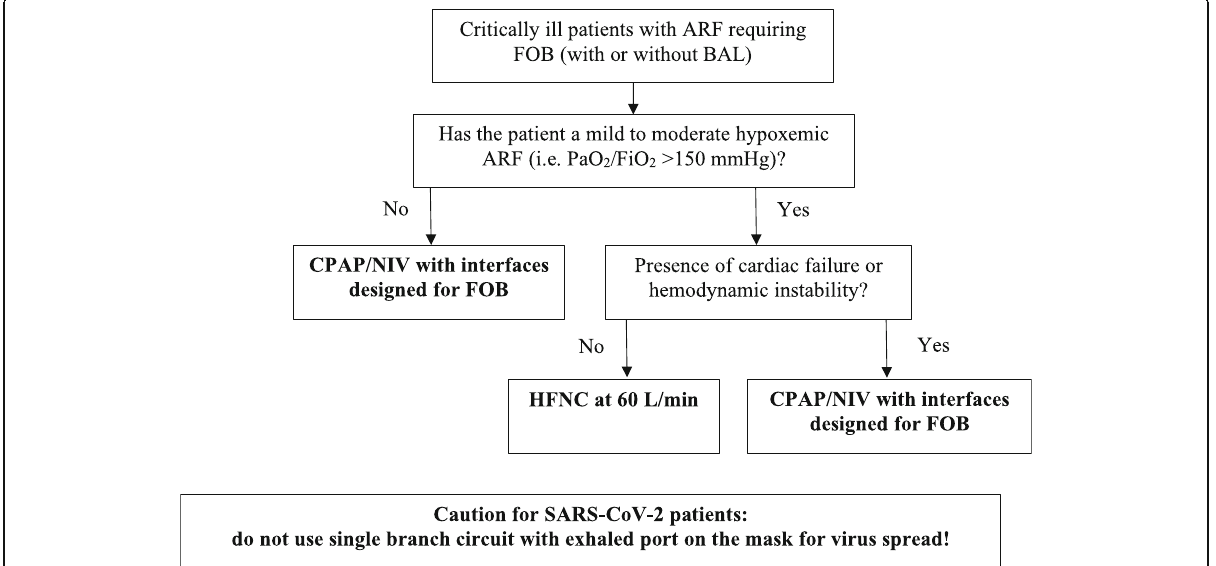
Fig. 1 Possible approach for FOB in ICU in non-intubated patients. ARF, acute respiratory failure; FOB, flexible fiberoptic bronchoscopy; BAL, bronchoalveolar lavage; PaO 2 /FiO 2 ratio between arterial partial pressure of oxygen and inspired oxygen fraction; CPAP, continuous positive airway pressure; NIV, non-invasive ventilation; HFNC, high-flow oxygen through nasal cannula; SARS-CoV-2, severe acute respiratory syndrome coronavirus